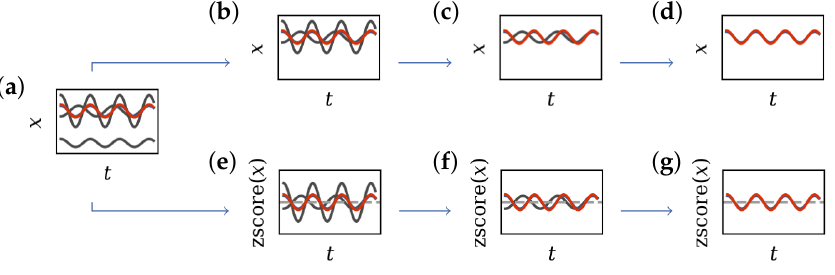
Figure 4. Procedures of the proposed similar time series search method. ( a – d ) Strictly similar time series search; ( a , e , f , g ) Search of time series with similar